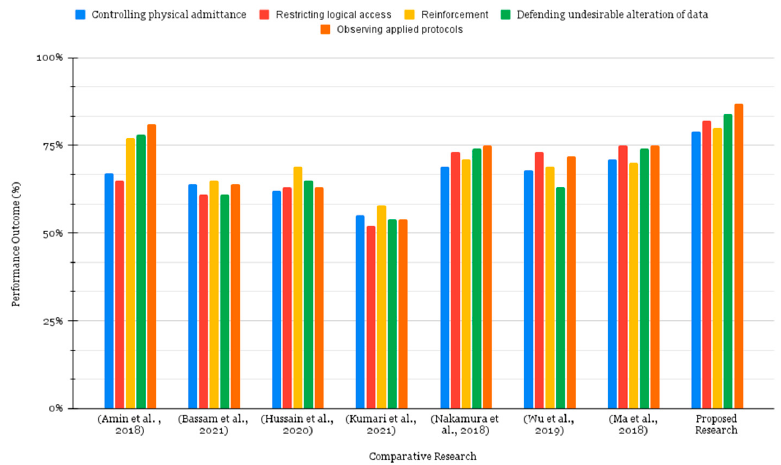
Figure 8. Comparative analysis.